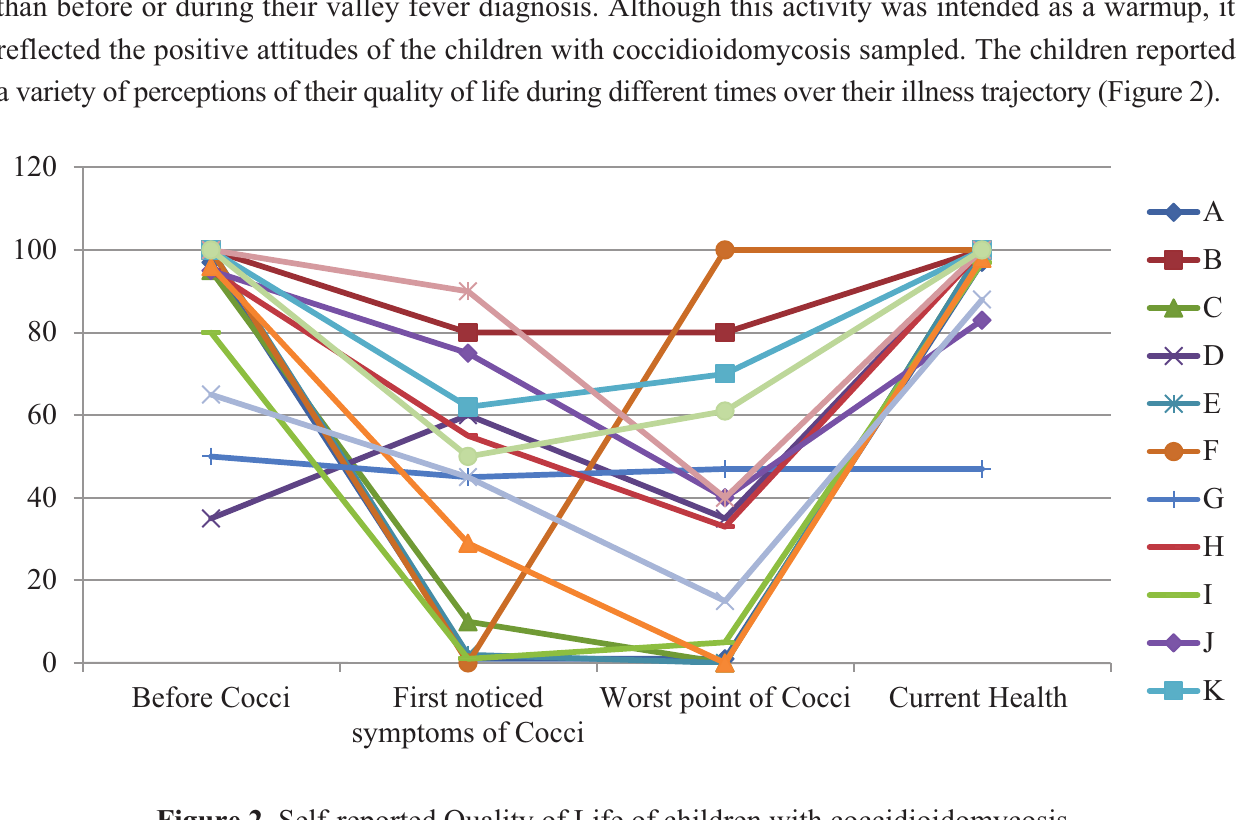
Figure 2. Self-reported Quality of Life of children with